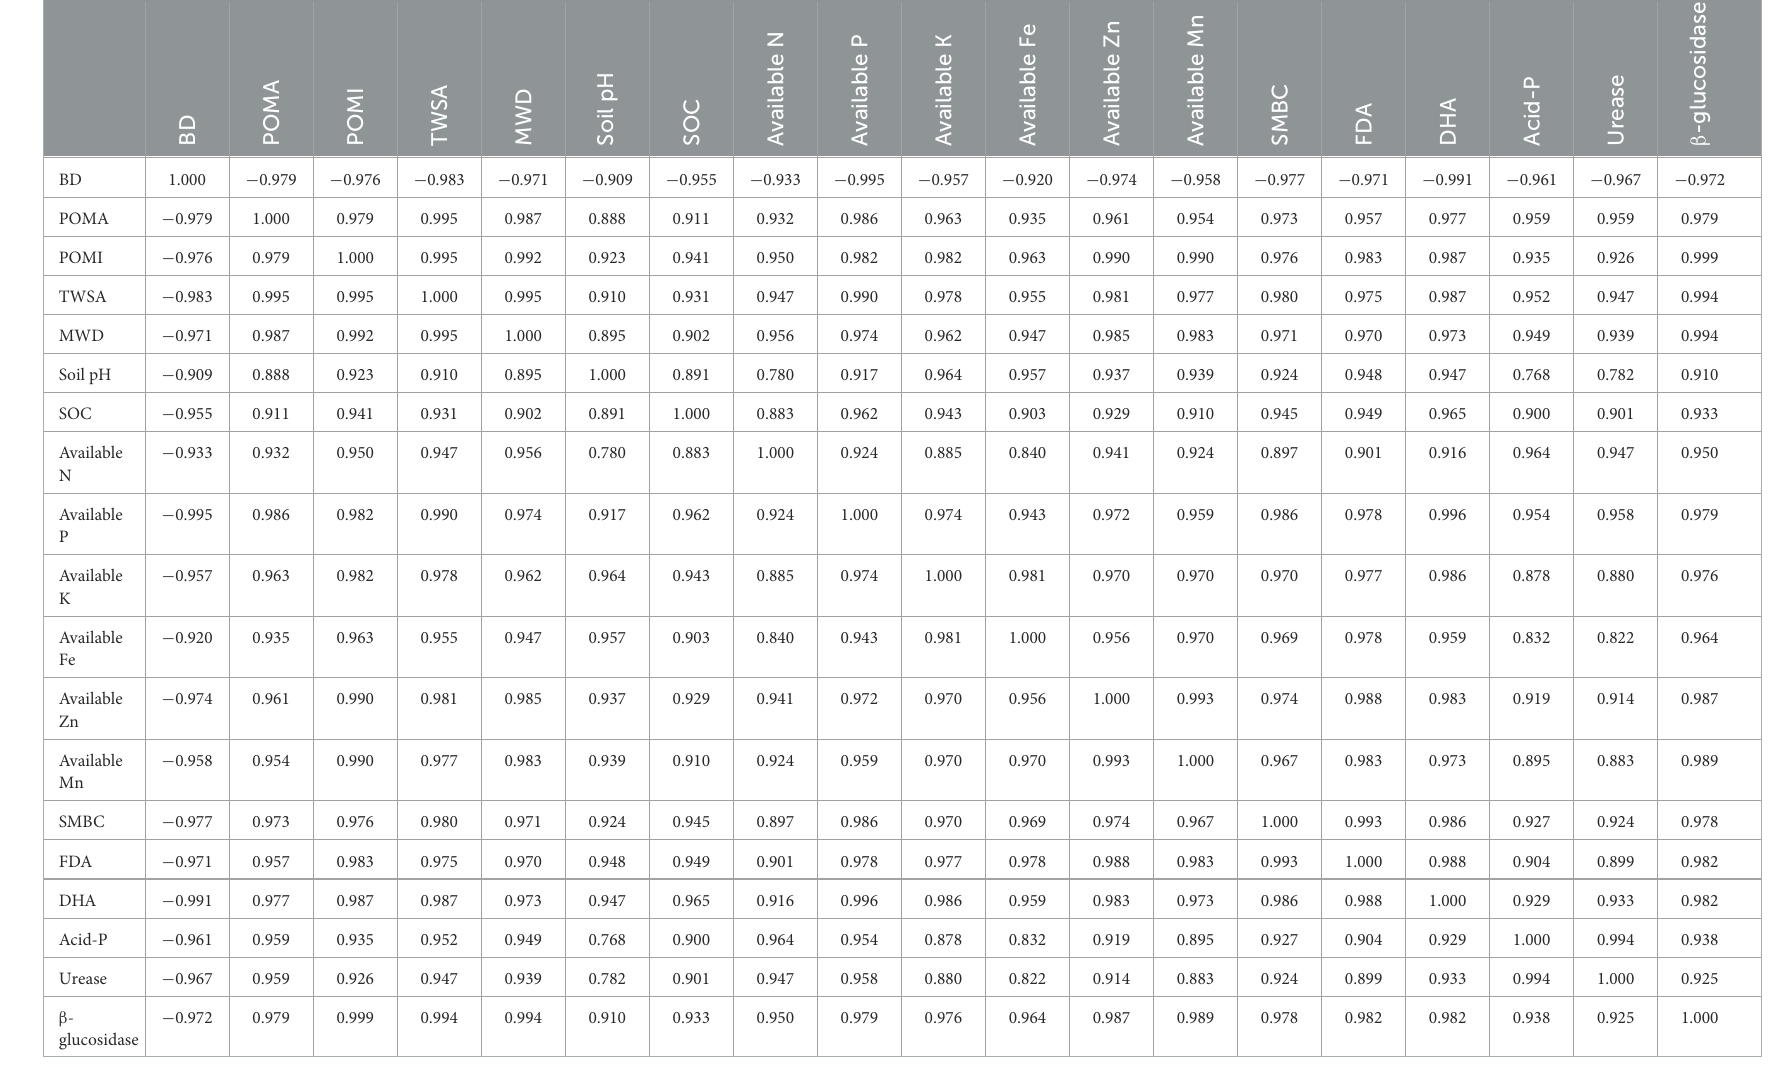
TABLE 2 Correlation matrix between soil physical, chemical, and biological